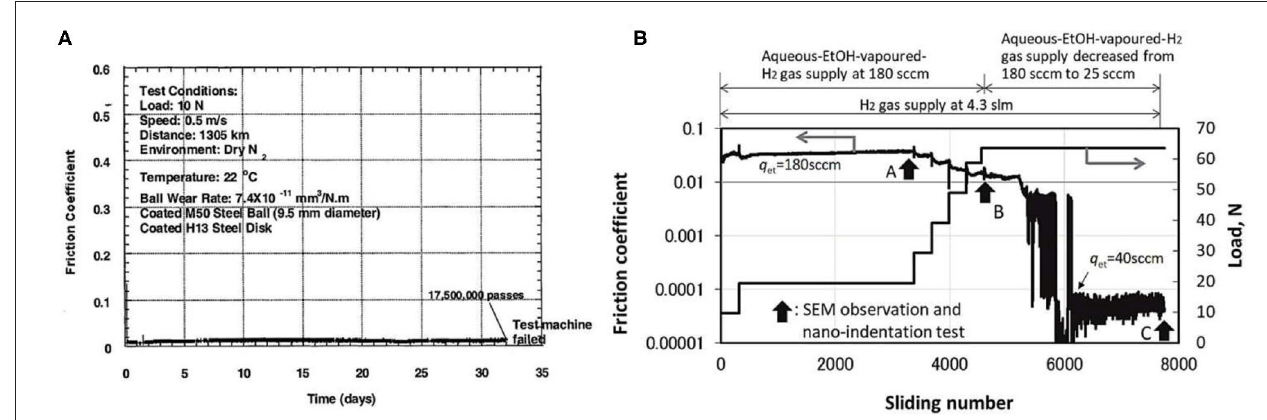
FIGURE 1 | (A) Superlubricity with extremely long-lasting time of 32 days achieved with a-C:H films in N 2 environment. Adapted with permission, Erdemir et al. (2000b) Copyright 2000, Elsevier Science B.V. (B) Extremely low friction coefficient below 0.0001 achieved with a-C:H films in H 2 environment under heavy load. Adapted with permission from Nosaka et al. (2017) Copyright 2017, Japanese Society of